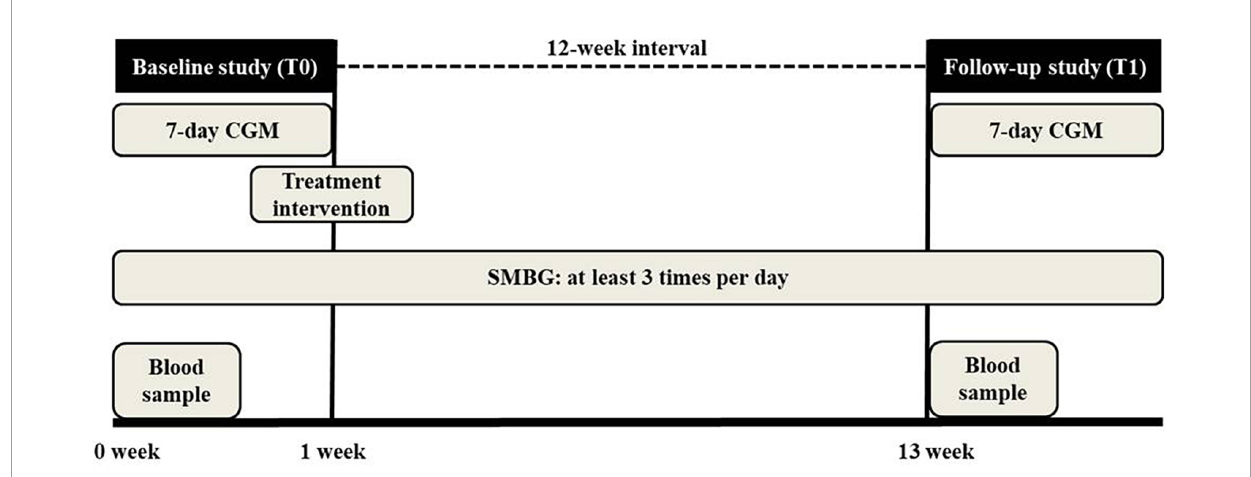
FIGURE1 Study protocol. Patients underwent 7 days continuous glucose monitoring (CGM) twice at a 12 weeks interval. In the baseline study period (T0), physicians and patients measured the basal glucose levels and glycemic markers without intervention. Physicians modified the treatment strategy based on the T0 results. After 12 weeks, the follow-up study (T1) was conducted. Patients checked self-monitoring capillary blood glucose (SMBG) at least three times per day during the